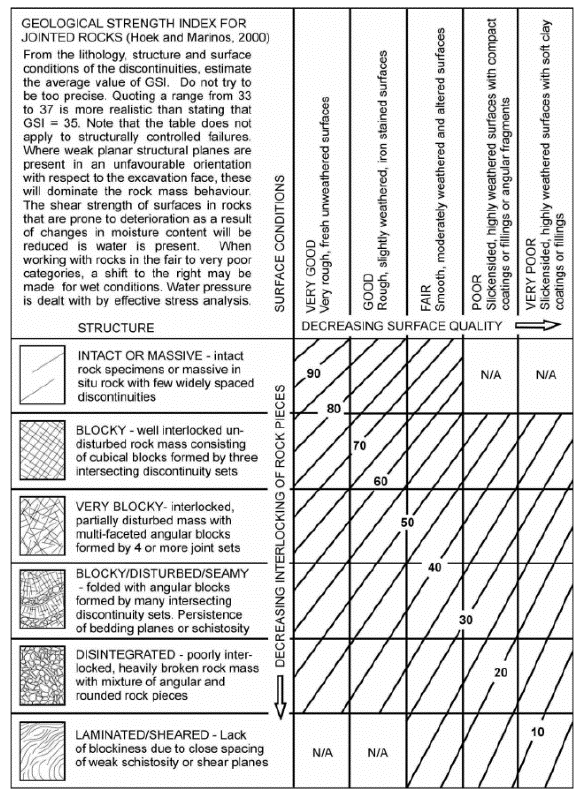
Figure A4. GSI chart for jointed rock masses [24].